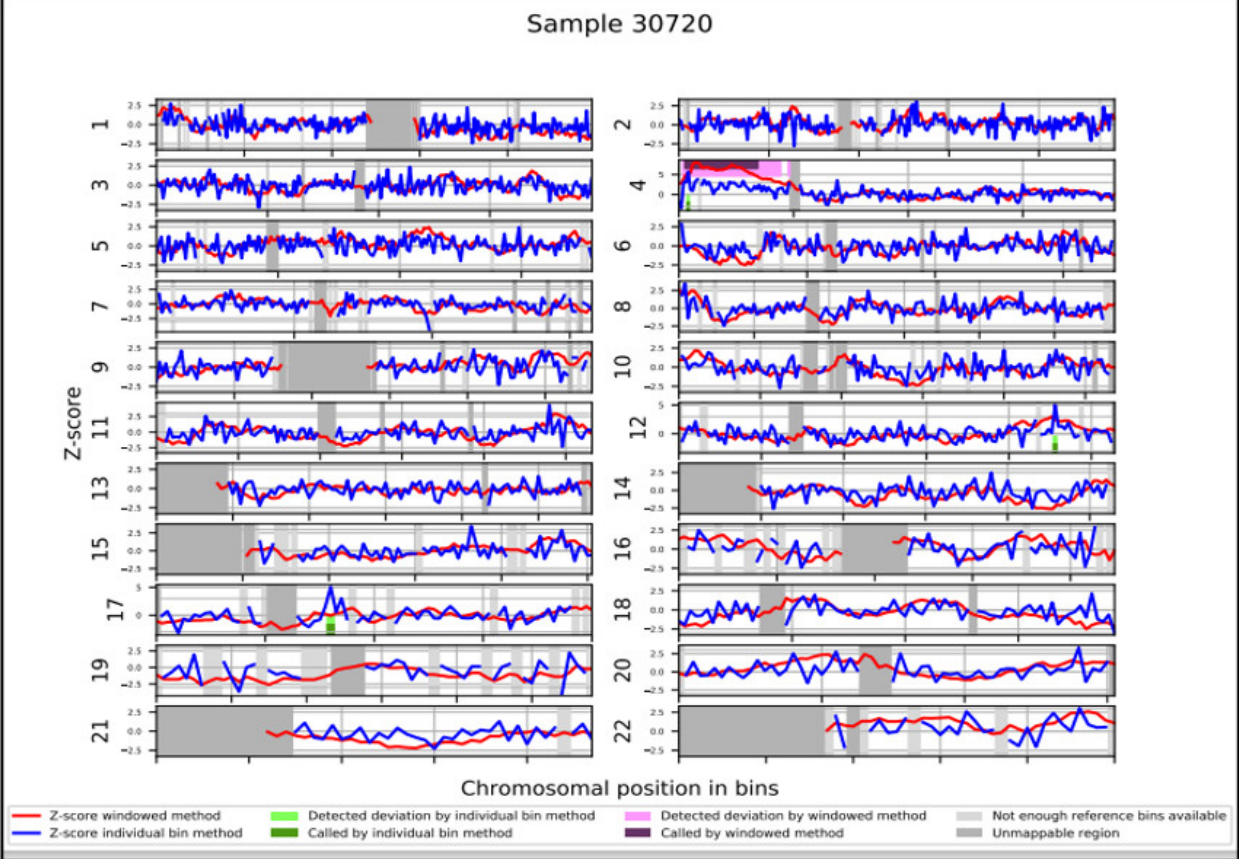
Figure 1. NIPT results. WISECONDOR plot showing the abnormal NIPT result with a duplication of short arm of chromosome 4.